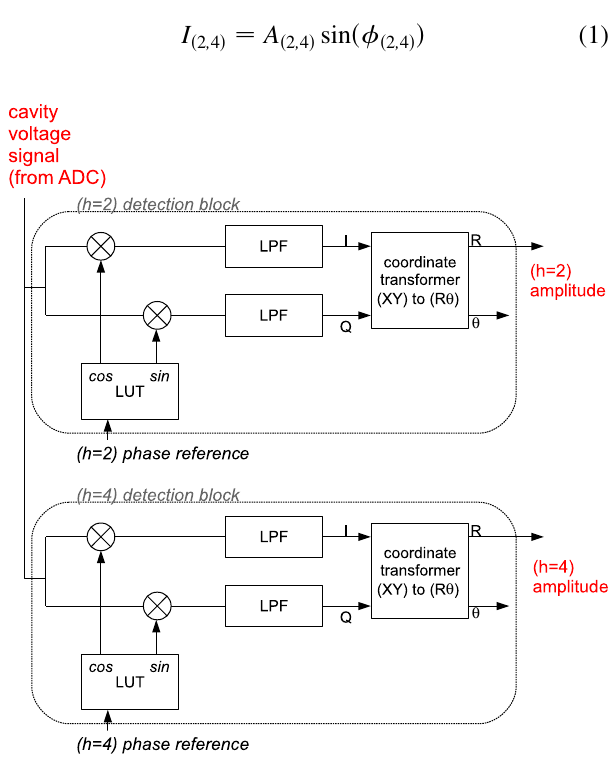
FIG. 7. (Color) Details of the harmonic-detection